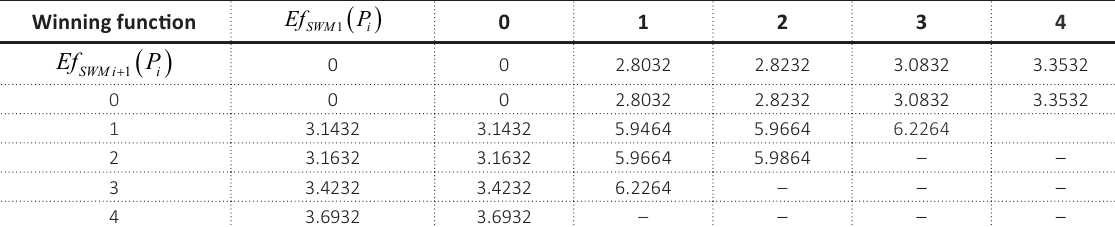
Table 6. Calculation of maximum winnings for options Winning